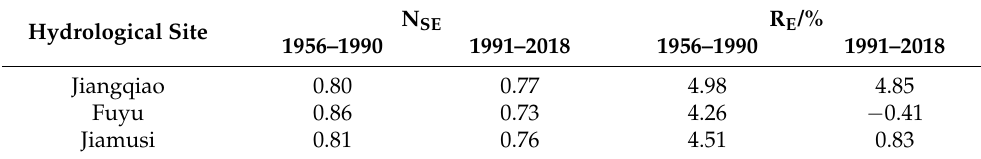
Table 1. Validation of the WEP-N model at the Jiangqiao, Fuyu, and Jiamusi Stations. Hydrological Site